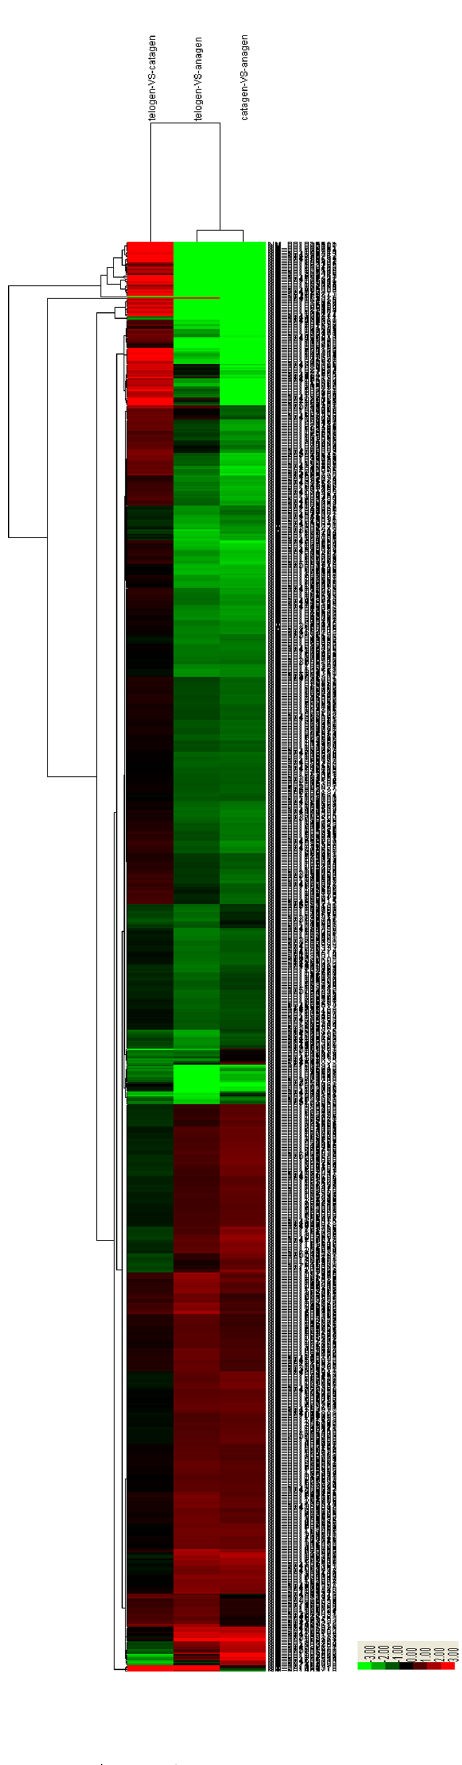
Figure 4. Hierarchical cluster analysis of gene expression based on log ratio RPKM data. The red color represents upregulated genes and the green color represents downregulated genes. There were clusters with relatively minor differences between anagen vs. catagen and anagen vs. telogen, but marked differences with catagen vs.